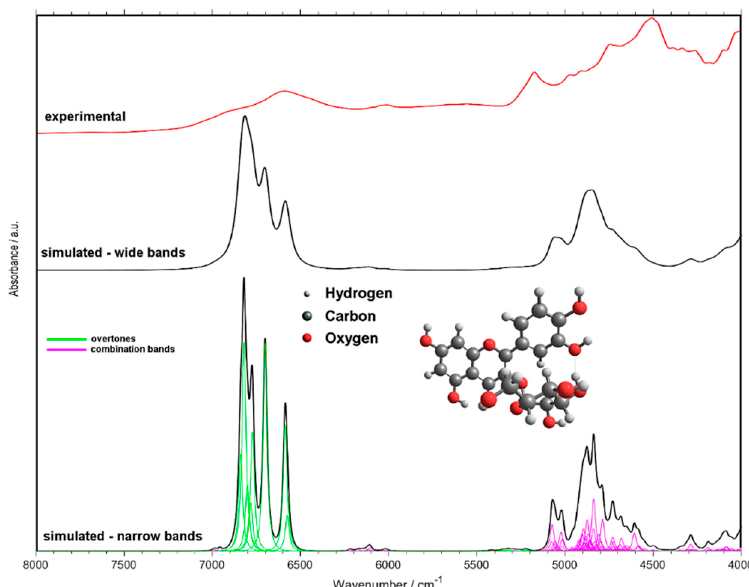
Figure 5. NIR spectrum of cyanidin-3-O-glucoside simulated with use of quantum chemical calculations. Two arbitrary bandwidth levels shown for simulated spectra for the purpose of the discussion. Experimental spectrum was measured for pure standard, polycrystalline cyanidin-3-O-glucoside.